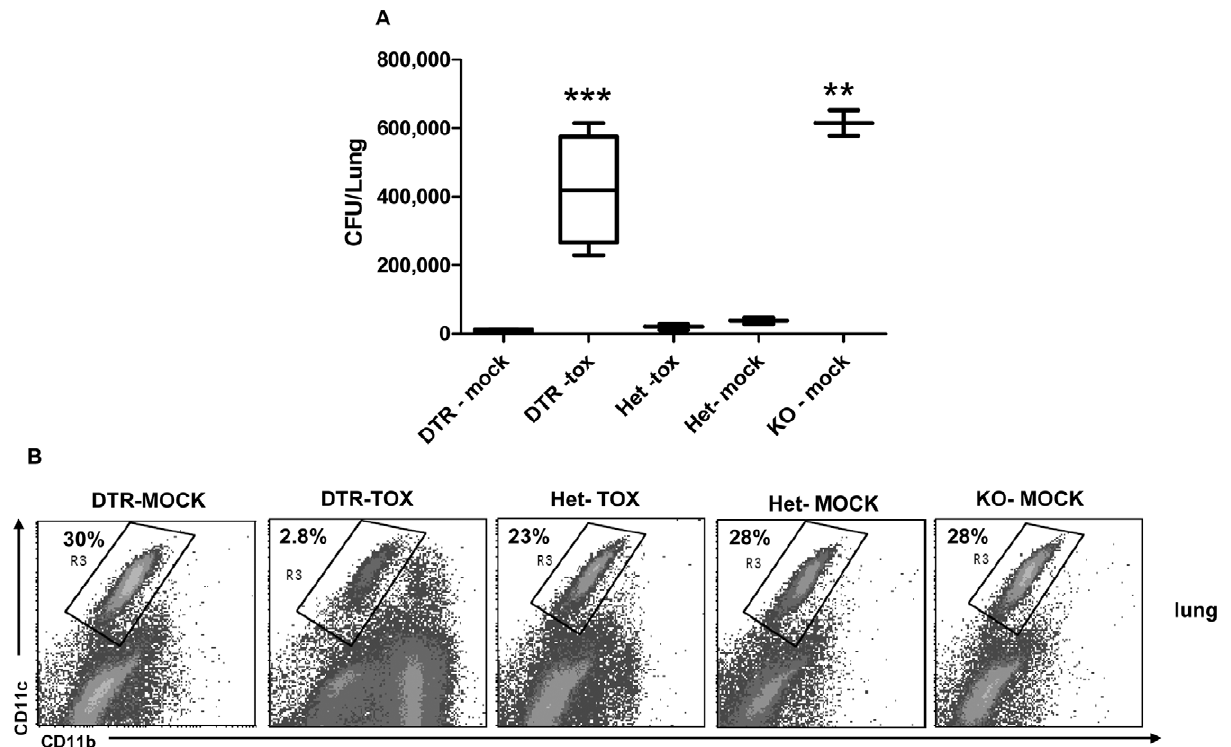
Figure 5. Bacterial load in lungs following invivo ablation of lung CD11c + cells. CD11c:DTR mice (C57BL/6 genetic background) were treated intratracheally with DTx (100 ng/gr, DTR-tox group). CD11c:DTR littermates treated intratracheally with PBS (‘DTR-mock’) served as control. Ncr1 + /gfp C57BL/6 mice treated intratracheally with DTx (‘Het-tox’) or with PBS (‘Het-mock’) and Ncr1 gfp/gfp C57BL/6 mice treated with PBS (‘KO-mock’) served as additional control groups. One day after DTx or mock treatment, all mice were challenged with 5 6 10 7 CFU of S . pneumoniae strain WU2 and lungs were harvested 3 h after challenge. (A) CFU of S . pneumoniae in lungs, 3 h after bacterial challenge (n=3 to 5 per group). Results are presented as box plot of CFU . *** p , 0.001 compared with DTR-mock; ** p , 0.01, compared with Het-mock, 6 SD (ANOVA test). (B) Flow cytometry analysis of lung cells for CD11c and CD11b expression, 3 h after bacterial challenge (representative mouse). Numbers indicate percentage of gated cells from total white blood cells. Results are from one representative experiment of two.